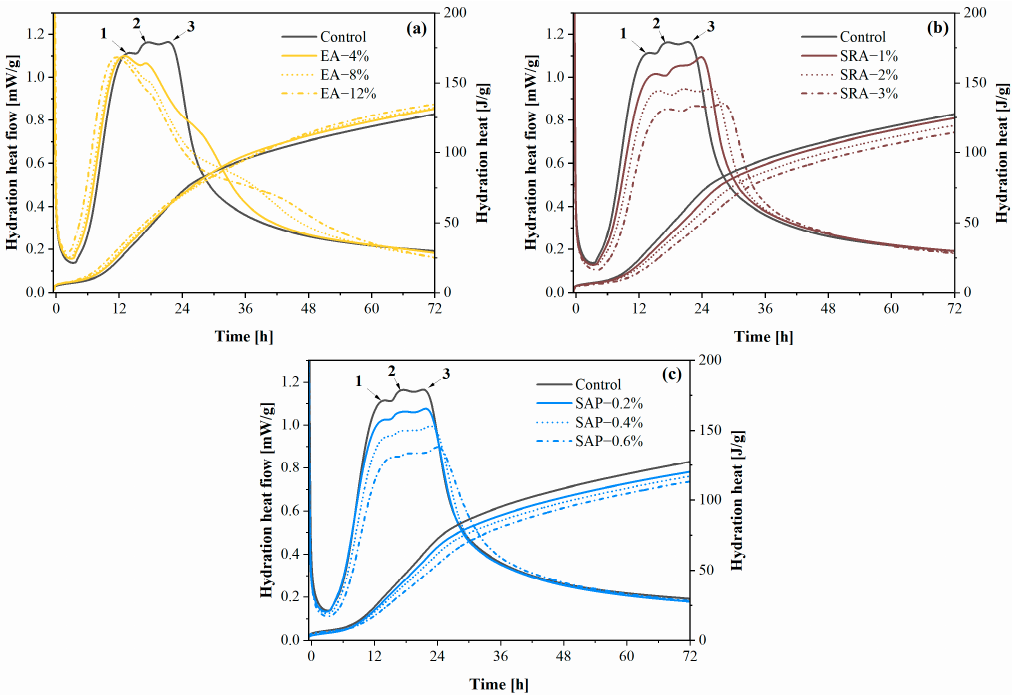
Figure 7. Hydration heat kinetics of pastes with different shrinkage compensation admixtures: ( a ) EA ( b ) SRA ( c ) SAP.